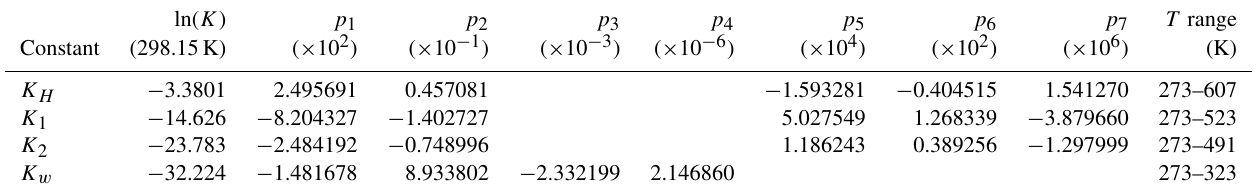
Table 4. Parameterization of the temperature-dependent equilibrium constants for the aqueous dissociation equilibria (Reactions R1–R4), applicable in the stated temperature range at pressures near 1atm ( ∼ 10 5